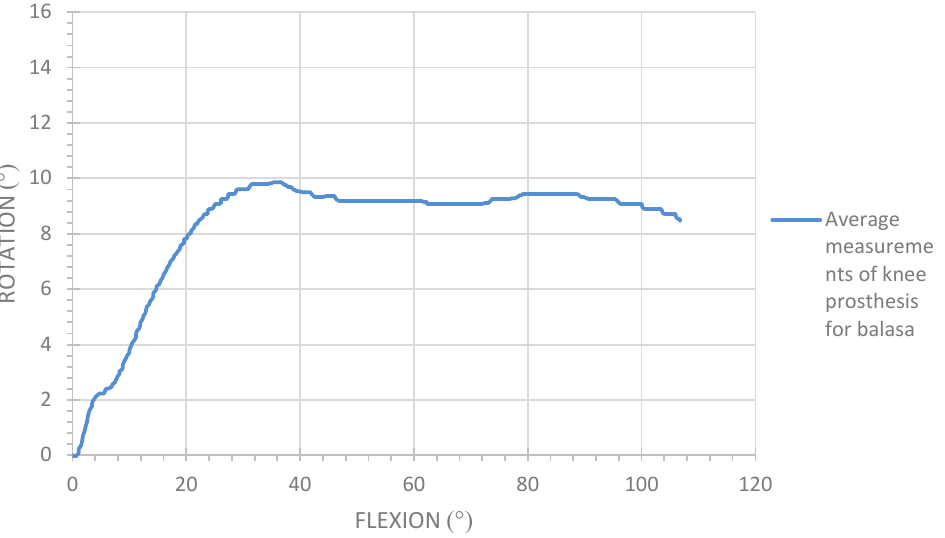
Figure 18. A graph of Rotation against Flexion for the prosthesis developed with a test machine [12].